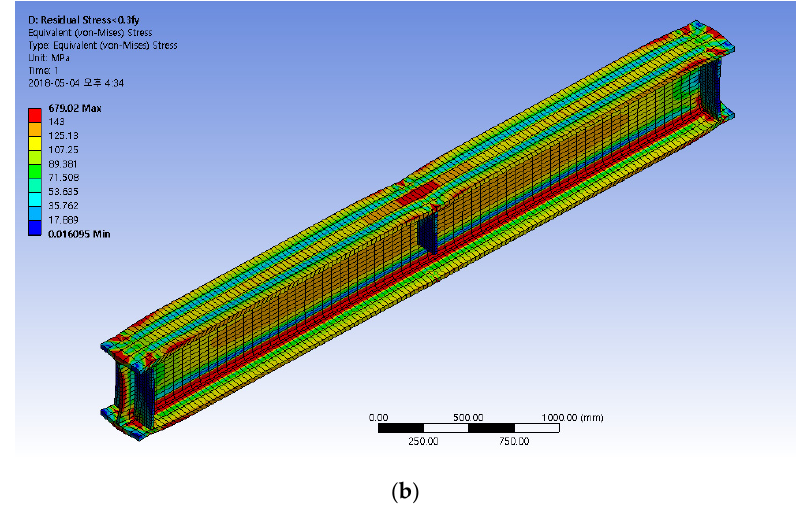
Figure 12. Thermal analysis result. ( a ) Temperature distribution; ( b ) equivalent stress distribution.